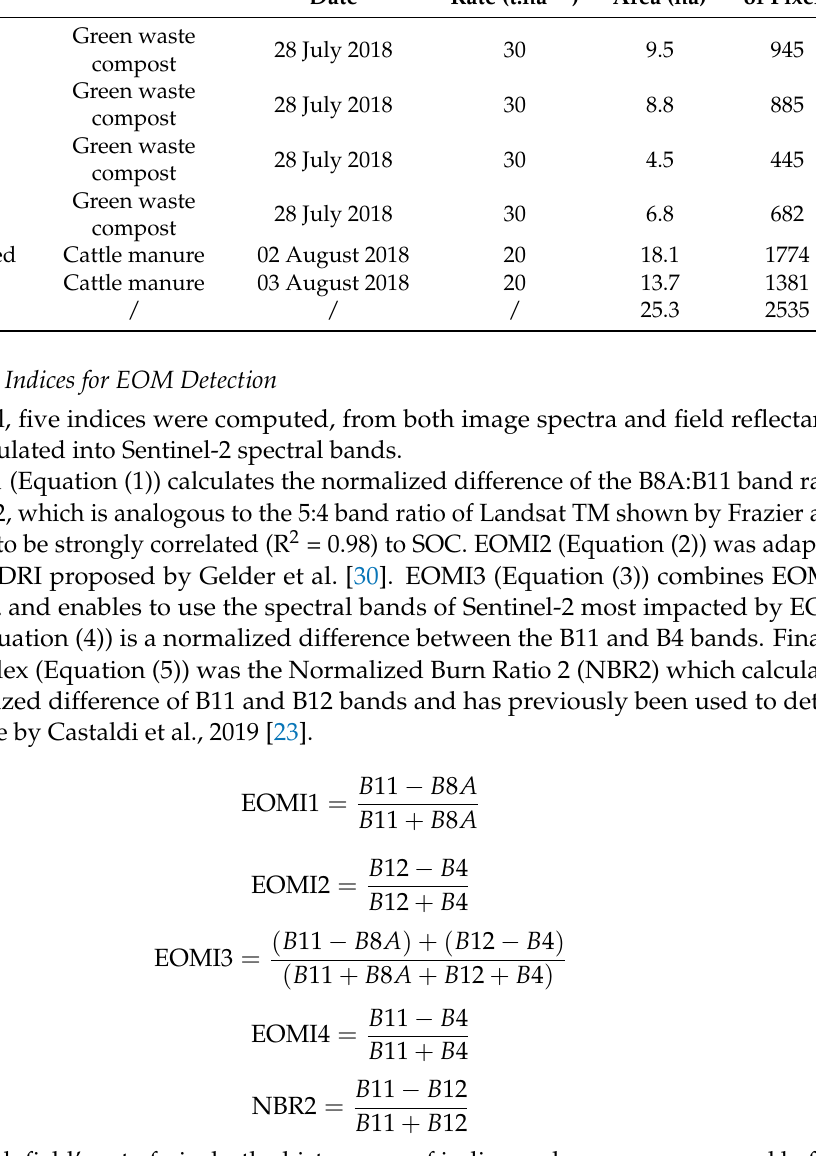
Table 2. Exogeneous organic amendment (EOM) data. Application date is approximated ± 2 days. Field